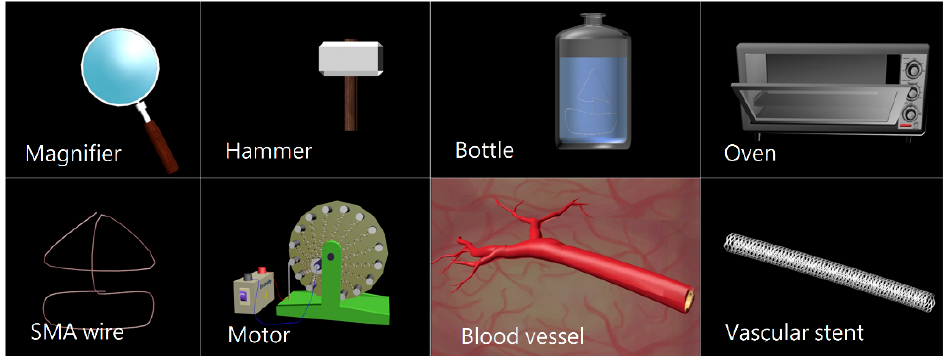
Figure 8. Using 3DS Max to design the 3D objects in the virtual experiment.